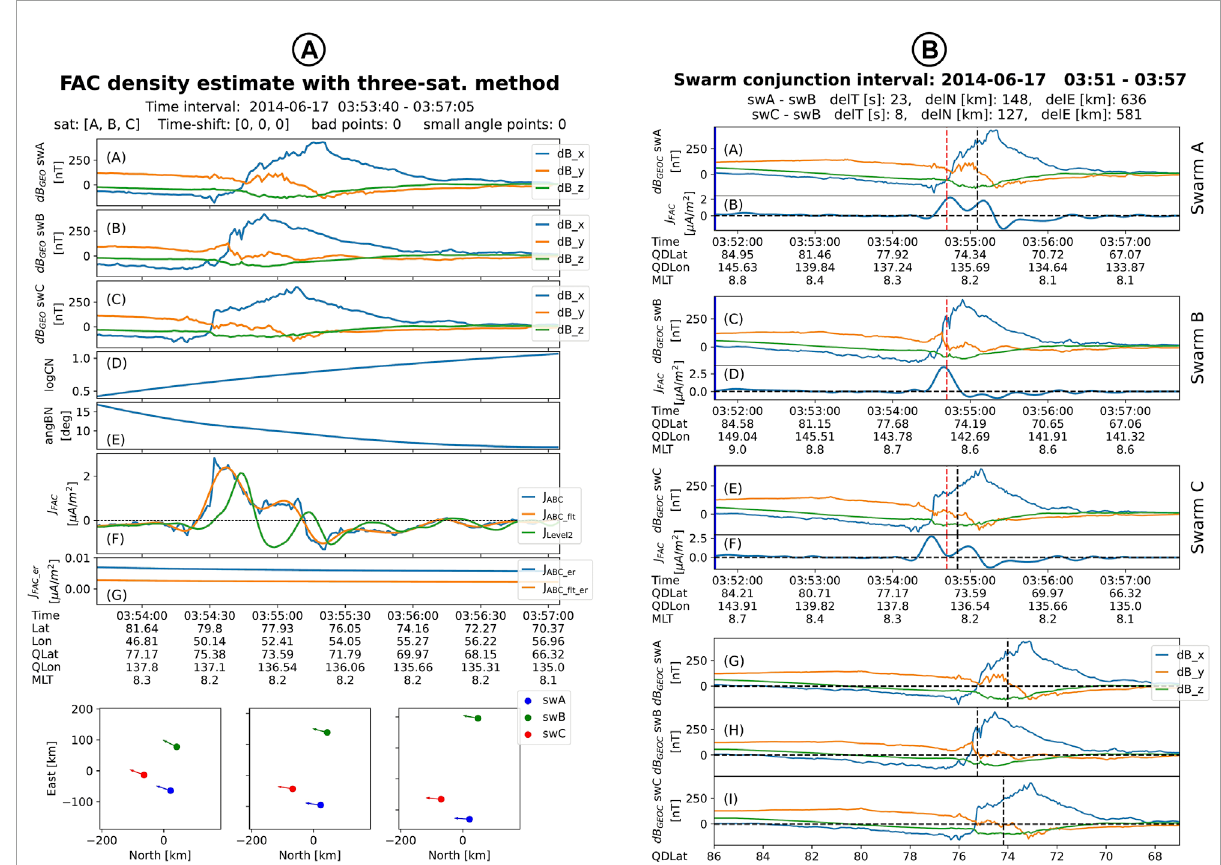
FIGURE 4 (A) : Standard plot generated by the j3sat algorithm. From top to bottom the figure shows (A–C) the magnetic field perturbation recorded by the Swarm satellites in GEO frame, (D) the logarithm of the condition number, (E) the angle between B and the direction normal to the spacecraft plane, (F) comparison between the un-filtered and filtered three-satellite FAC estimations (blue and orange, respectively) and the Level-2 dual-satellite product (green), and (G) the error level in FAC density estimation(s). At the bottom, the spacecraft configuration at start time, stop time, and at the middle of the interval is presented as projection on the North-East plane of the local NEC frame. (B) : Standard plot generated by the find_3sat_conj algorithm. The magnetic field perturbation in GEO panels (A, C, and E) and the low-pass filtered single-satellite Level-2 FAC density data (panels (B, D, and F) are plotted for each satellite. The panels (G, H, and I) present the magnetic field perturbation as a function of QDLat. The auroral central times/location are shown as vertical black dotted lines. In panels (A–F) the auroral central time for Swarm B is indicated as reference (the red doted